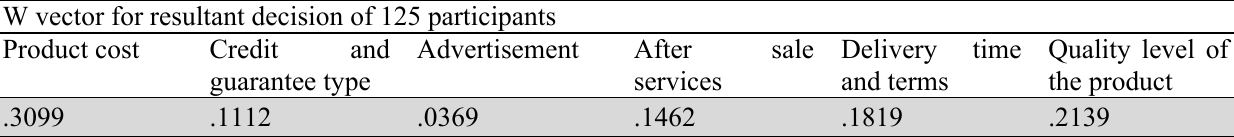
Prioritizing competitive factors W vector for resultant decision of 125